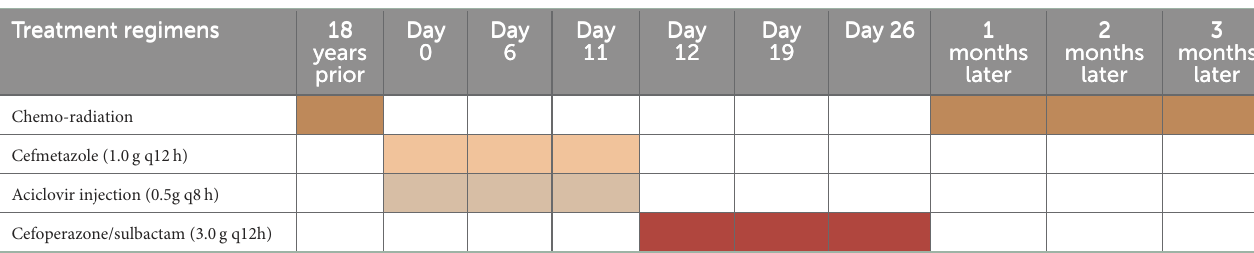
TABLE 2 Timeline of treatment